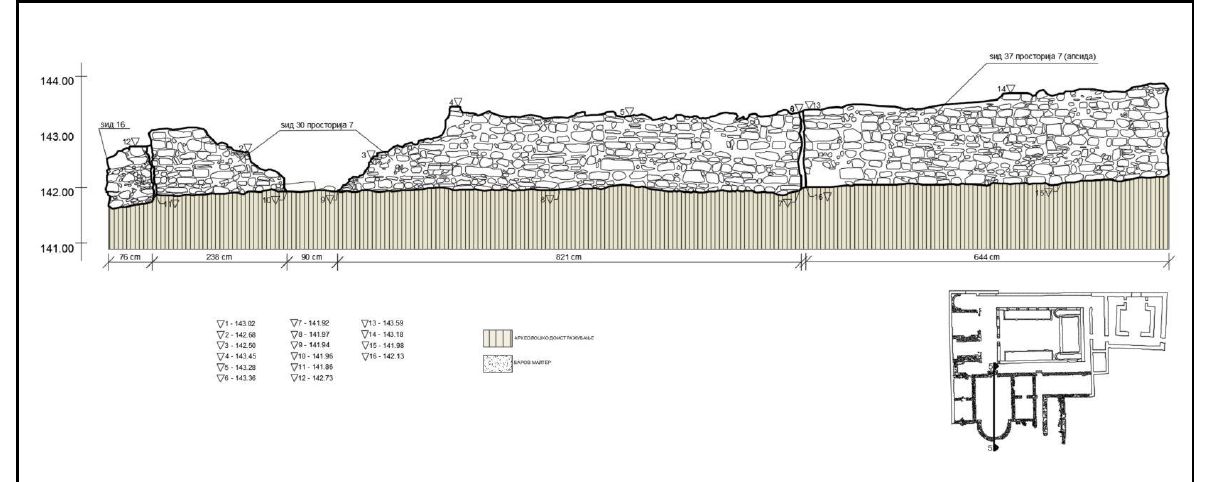
Figure 12. Completed Cross Section